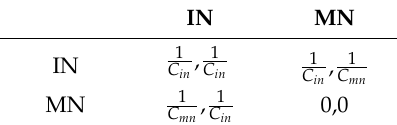
Table 1. The strategy form of two players.